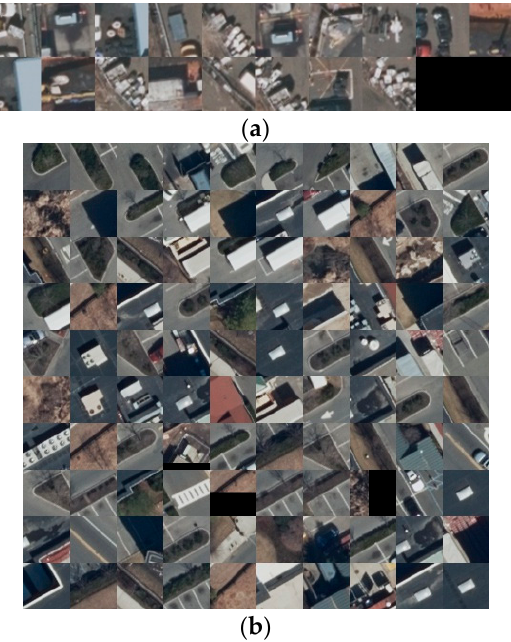
18 of 20 ( a ) ( b ) Figure A1. Visualization of undetected vehicle patches. ( a ) Undetected vehicles in test_1 image; ( b ) undetected vehicles in test_2 image. The red rectangle patch is covered by a shadow. As can be seen in Figure A1b, only one undetected vehicle was covered by any clutter or